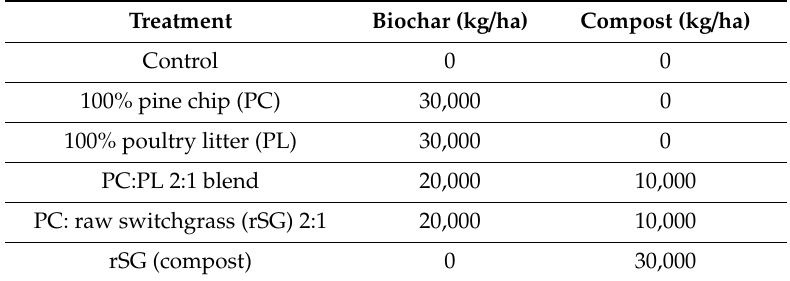
Table 2. Formulation and application of biochars and compost per treatment.